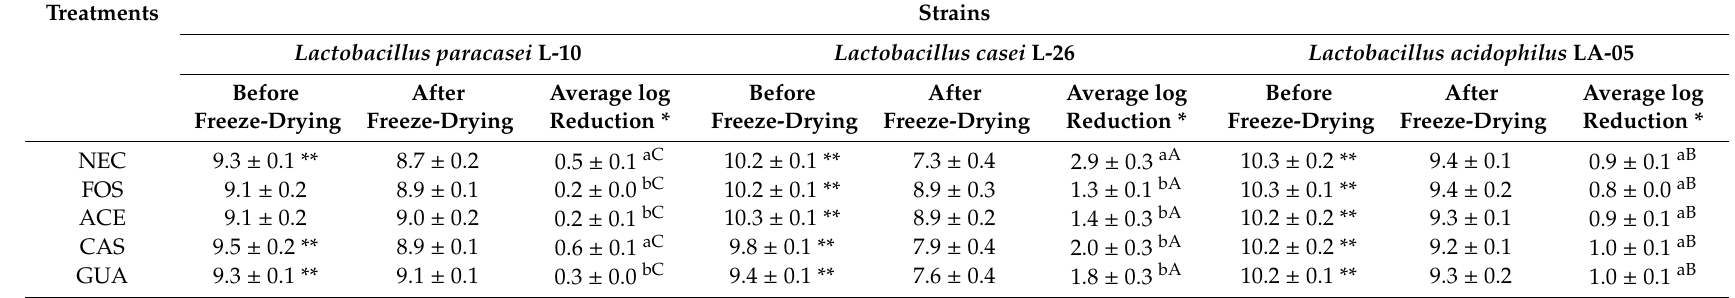
Table 2. Viable cell counts (log CFU / g) of probiotic Lactobacillus strains before and after freeze-drying without or with fructo-oligosaccharides, acerola, cashew, and guava processing